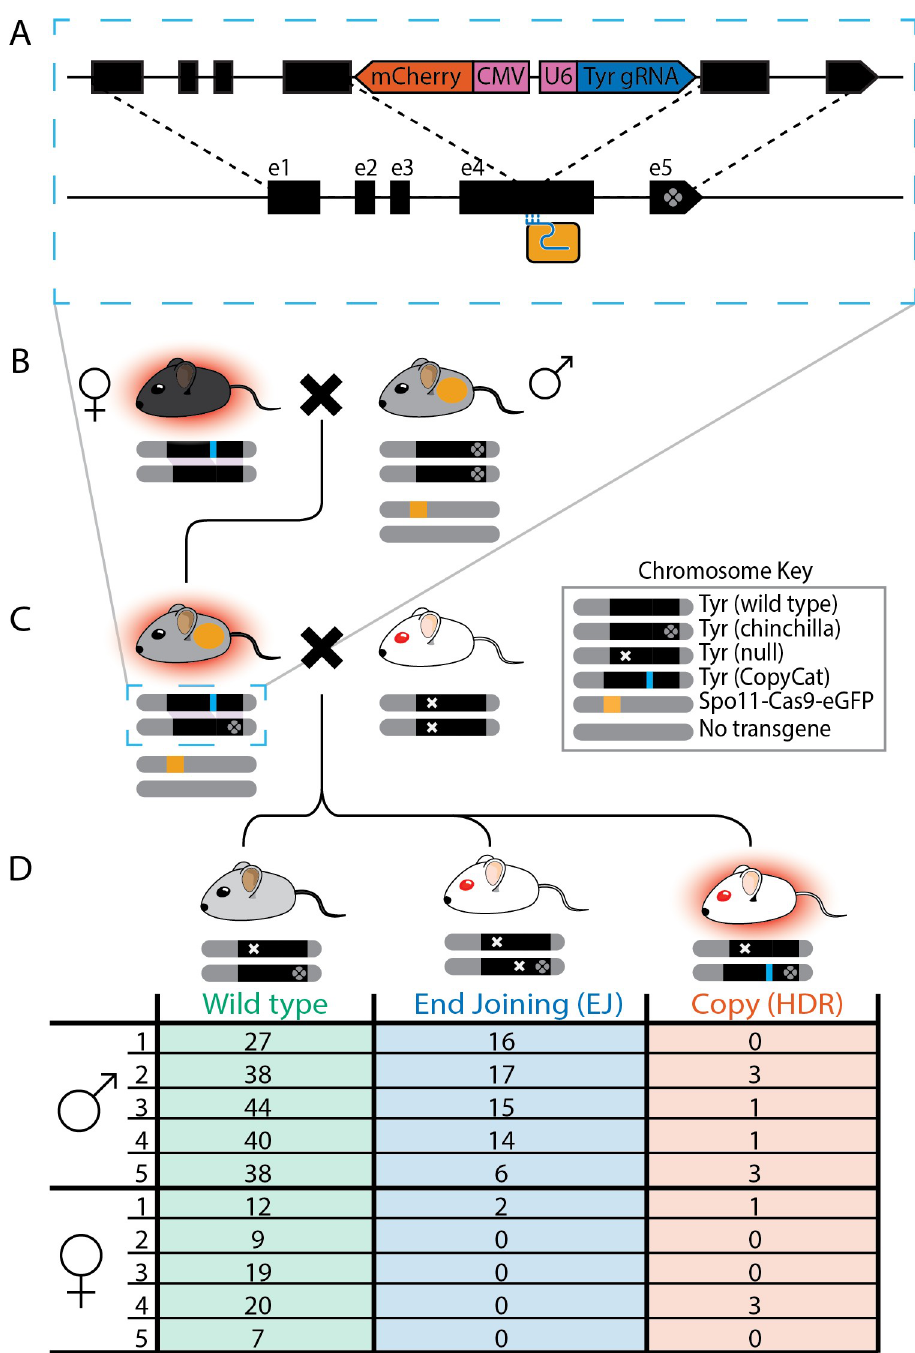
Fig 2. Breeding scheme to achieve gene conversion with summary table of results from Tyr ch offspring of complementation test crosses. (A) Schematic of the genetically encoded Tyr CopyCat transgene in Exon 4 of Tyrosinase (top chromosome) and its insertion into the recipient chromosome (bottom) during interchromosomal HDR. mCherry (red), CMV and U6 promoters (pink), and Tyr4a-gRNA (dark blue). Dotted lines indicate Tyr homology between chromosomes. Cas9 (light orange box) and gRNA (light blue) only target the wild-type Tyr allele. (B) Female Tyr CopyCat/+ crossed with male Spo11 Cas9-P2A-eGFP/+ ;Tyr ch/ch mice. (C) Complementation test cross of Tyr CopyCat/ch ; Spo11 Cas9-P2A-eGFP/+ male or female mice to albino Tyr null/null mice. (D) Numbers of Tyr ch offspring with each genotype in families (1 to 5) from male or female Tyr CopyCat/ch ; Spo11 Cas9-P2A-eGFP/+ parents. “Chromosome Key” shows genotypes of pictographic chromosomes under each mouse. The underlying data for each family can be found in the associated Zenodo data repository at (https://doi.org/10.5281/zenodo.5510697). EJ, end joining; gRNA, guide RNA; HDR, homology-directed